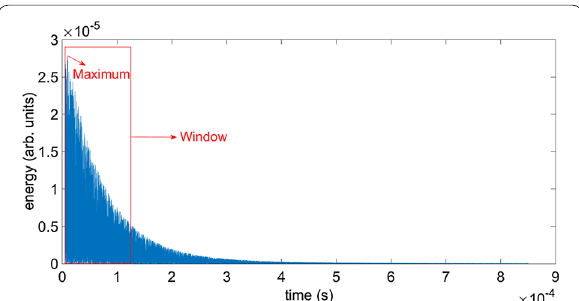
Figure 1 An example time trace of simulated incoherent noise for schematically illustrating the selection of windowed energy (with a window size, T ) and the maximum energy in arbitrary